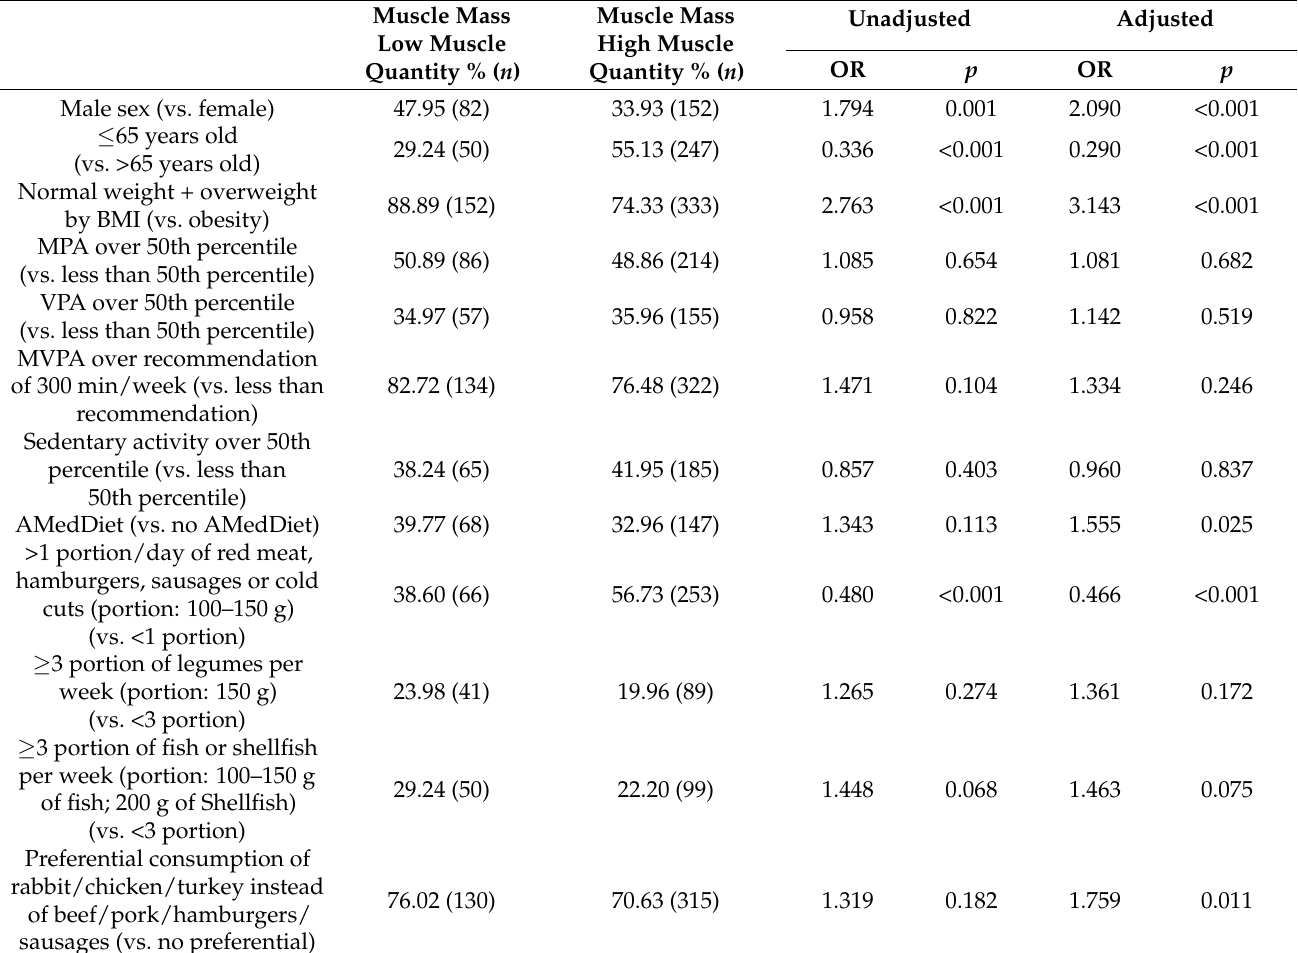
Table 5. Odds ratio of muscle quantity by muscle mass unadjusted and adjusted by sex and age. Muscle Mass Muscle Mass Unadjusted Adjusted Low Muscle High Muscle OR Quantity % ( n ) Quantity % ( n )